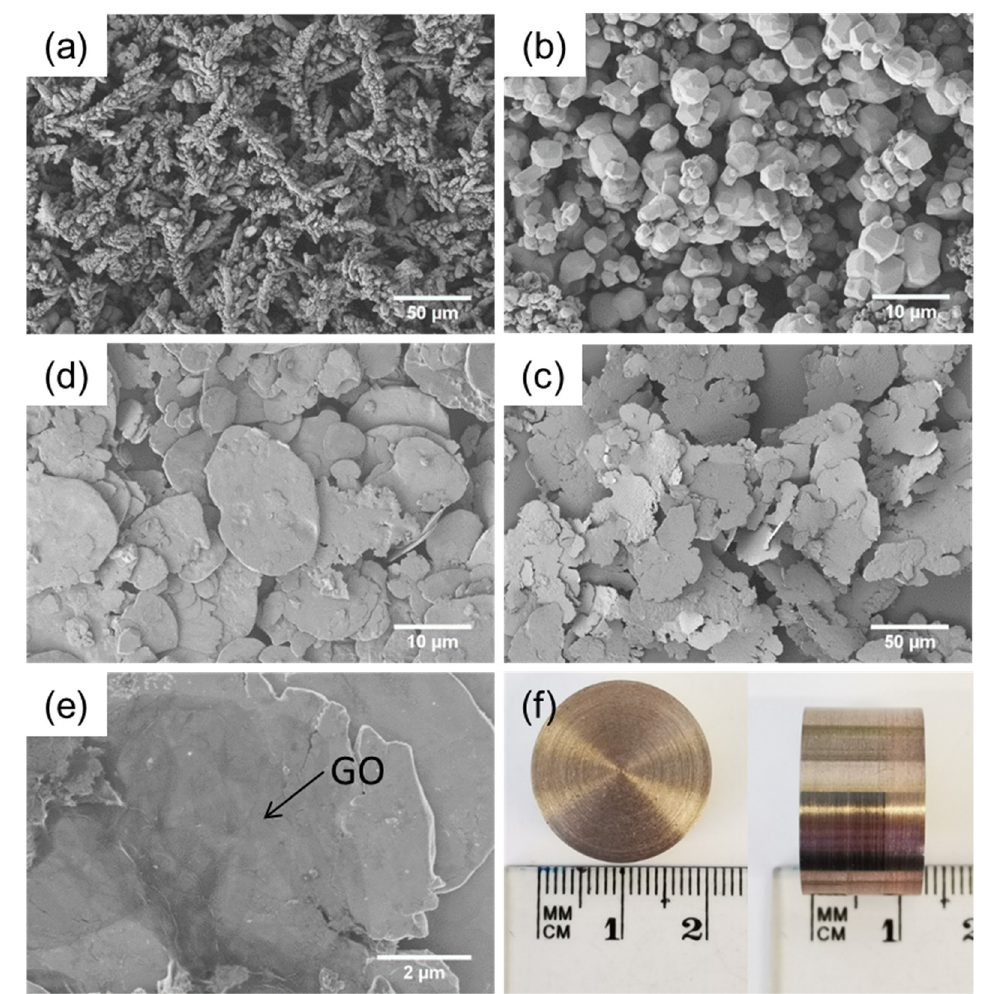
Figure 1. SEM images for raw ( a ) Cu, ( b ) W powders, ( c ) Cu flakes ball milled for 1 h, ( d ) W flakes ball milled for 1 h, ( e ) the flattened Cu-W powders with GO flakes (darker area), ( f ) the final bulk Cu-W-GO composite produced by SPS in the top and side view.